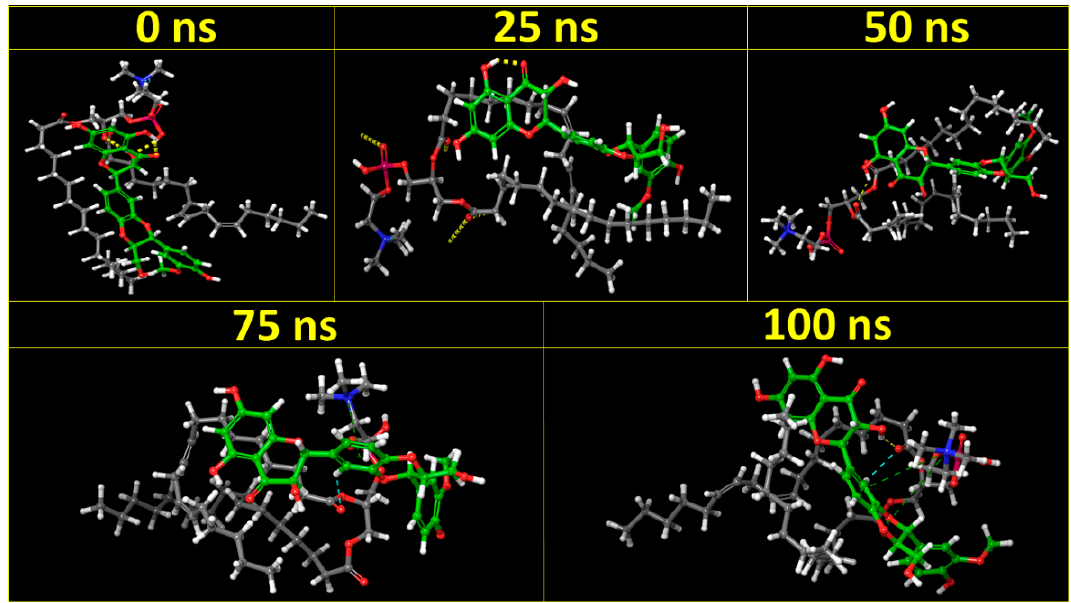
Figure 11. Molecular dynamic simulation of SIL–SPC complex at 0, 25, 50, 75 and 100 ns.